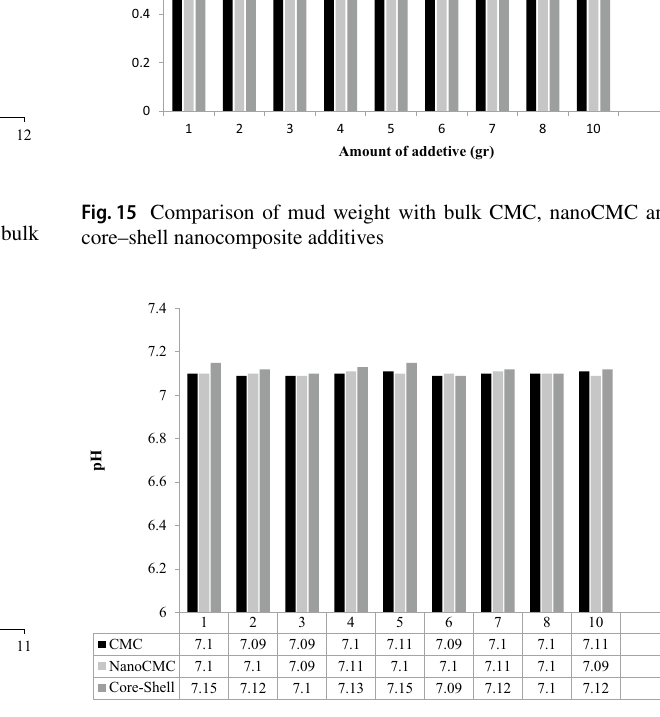
Fig. 16 Comparison of pH of drilling fluid with bulk